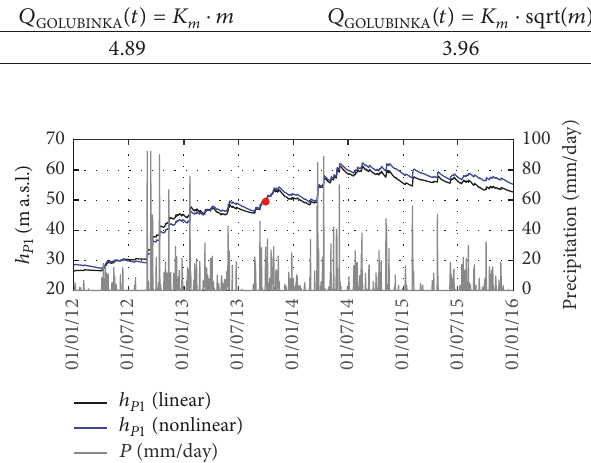
Figure 4: Groundwater level for the analyzed period 2012–2015 and the position of the reference piezometer 𝑃1 ; calculations according to (1); red dot represents measured value (49.5 m